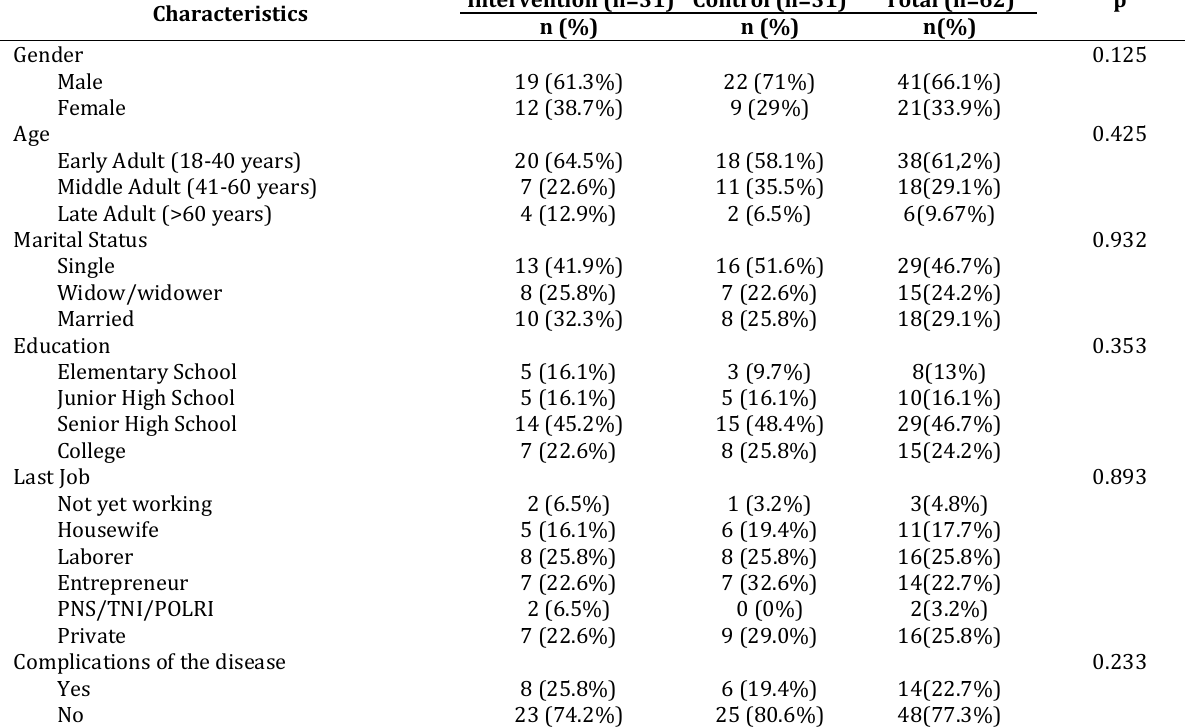
Table 1. Distribution of Both Groups regarding Their Sociodemographic Characteristics Characteristics